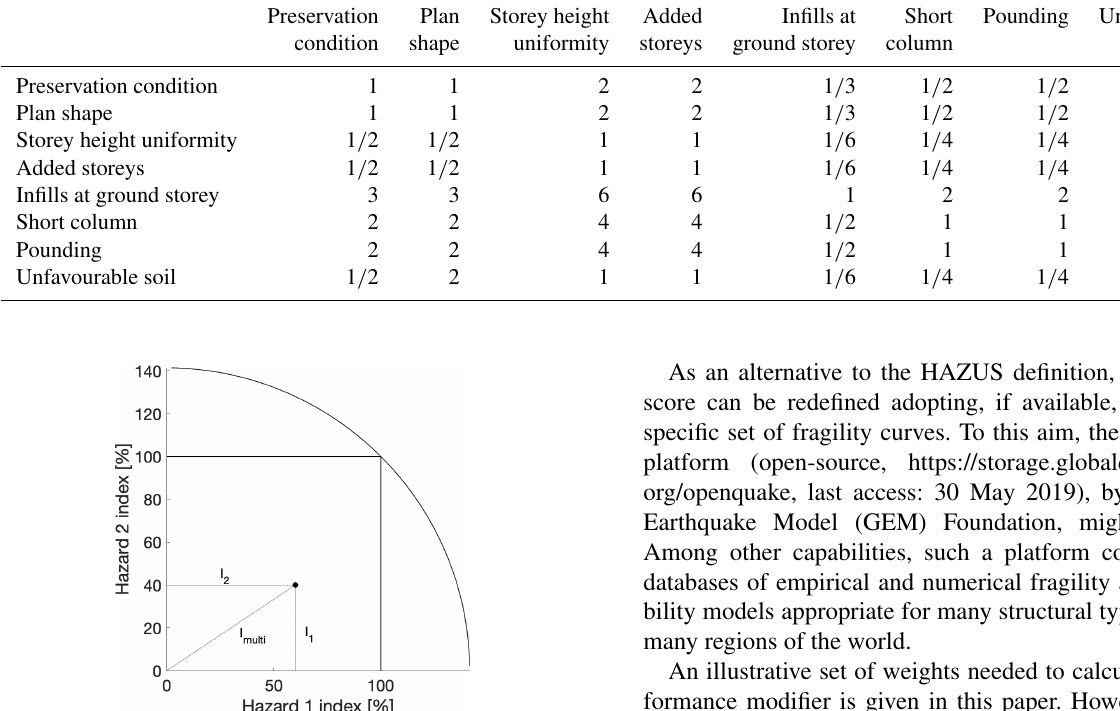
Table 5. Judgement matrix adopted for the calibration of the weights. Preservation